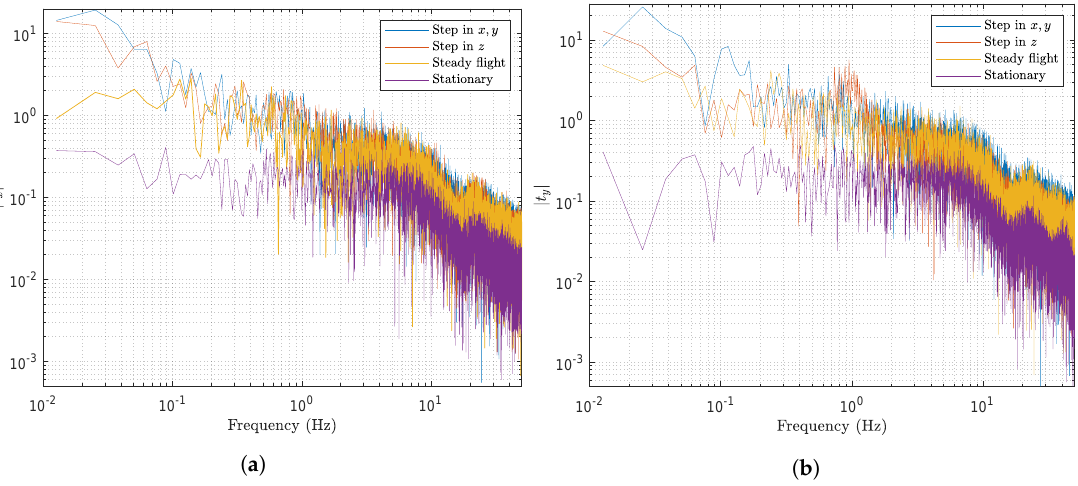
Figure 8. Signal analysis. ( a ) FFT of four different experiments wrt. t x ; ( b ) FFT of four different experiments wrt. t y